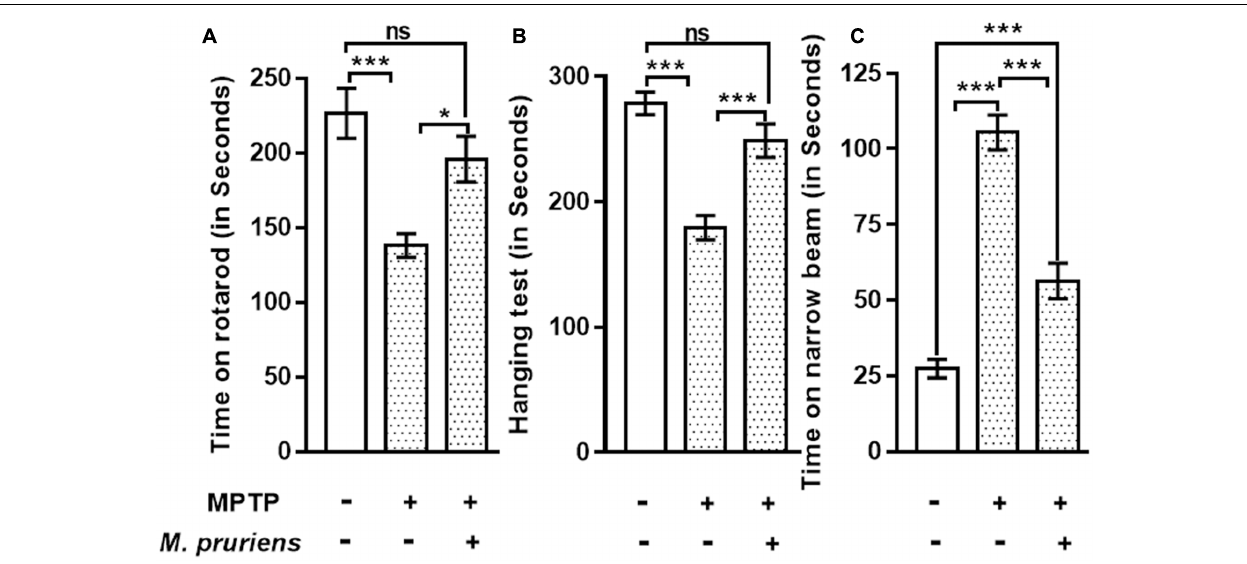
FIGURE 2 | Effect of Mp extract on behavioral parameters. (A) MPTP PD mice showed significantly reduced time of walking and staying on rotarod as compared to CONT group, which has been significantly improved on Mp supplementation to PD mice in comparison with untreated PD mice. (B) Hanging test showed significant improvement in Mp treated group compared to MPTP treated group. MPTP group mice fall early as compared to CONT group. (C) Narrow beam walking time was significantly increased in the MPTP treated mice in comparison with control group while Mp treatment declines the narrow beam walking time as compared to MPTP induced PD mouse ( ∗ p < 0.05, ∗∗ p < 0.01, ∗∗∗ p < 0.001, n = 6). ns,